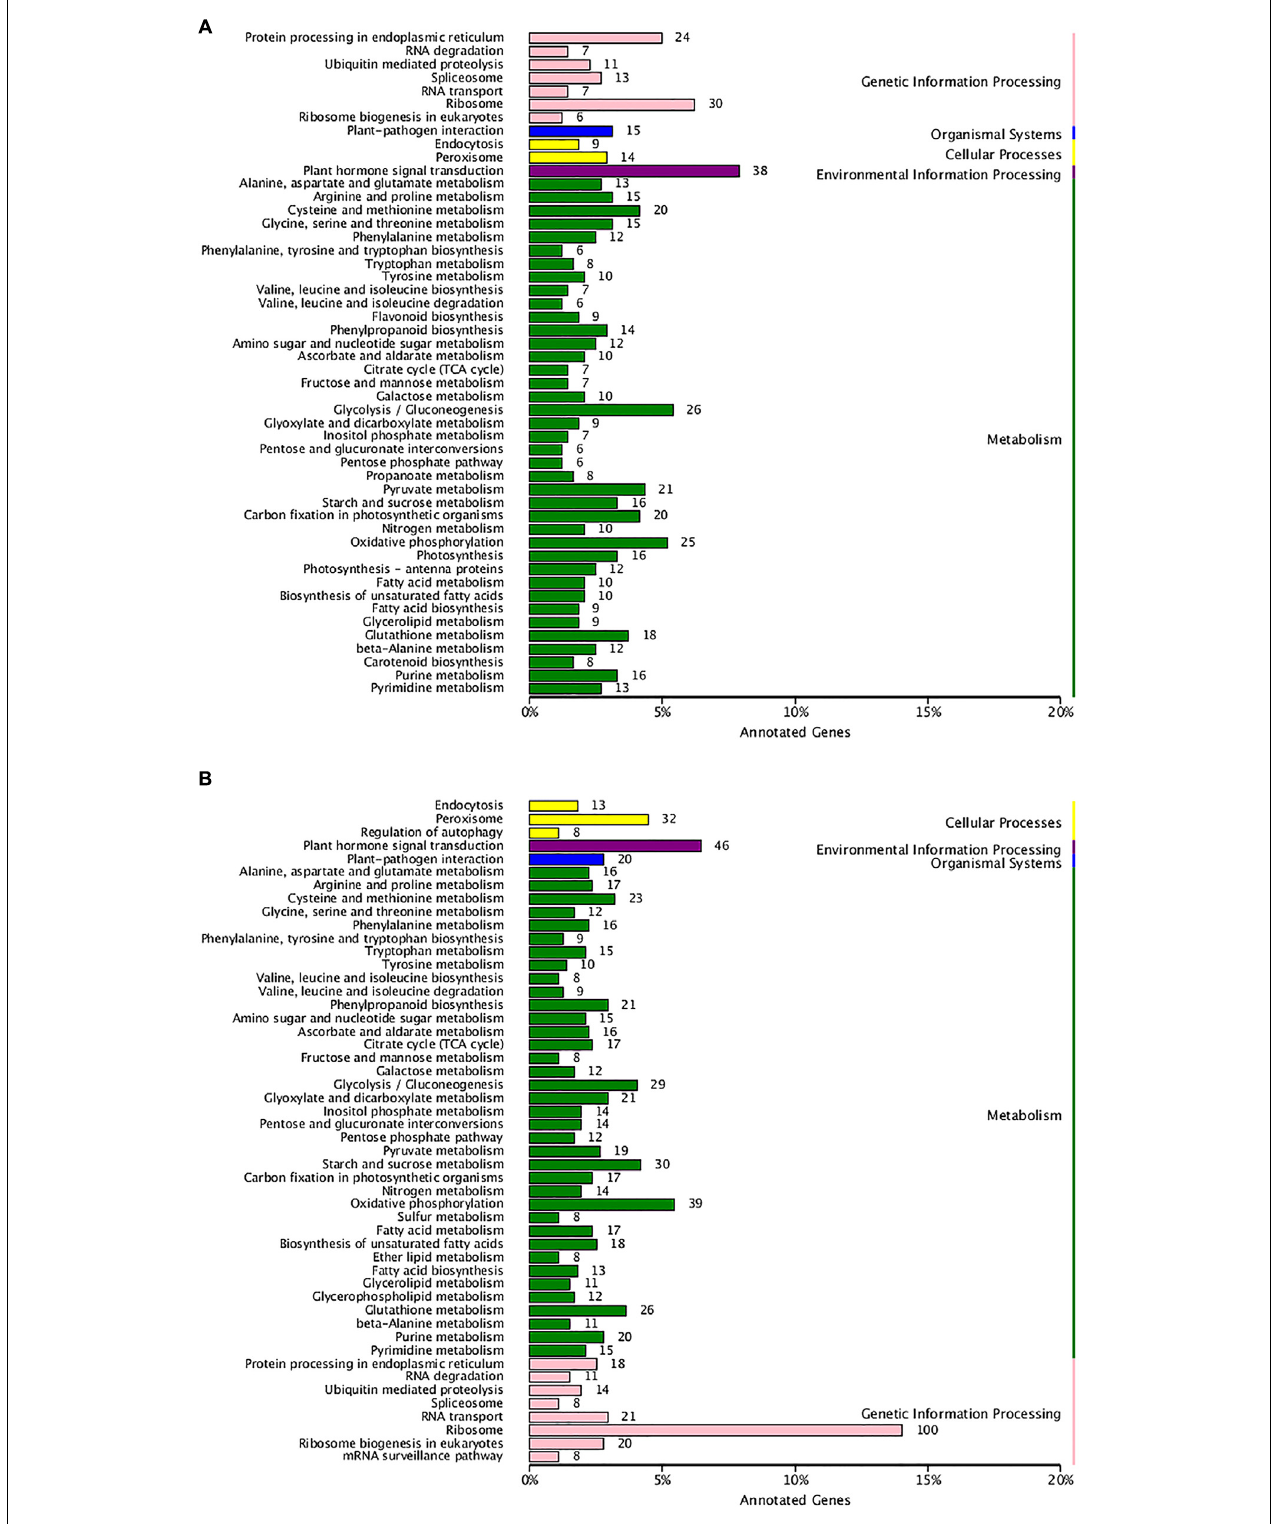
FIGURE 5 | The enriched pathways of significant DEGs. (A) For RRSIV and QJXIV and (B) for RRSV and QJXV. Ordinate: nomenclature of the KEGG metabolic pathway; abscissa: gene numbers that annotated this pathway and the ratio of KEGG in all genes that annotated relative to the total KEGG.